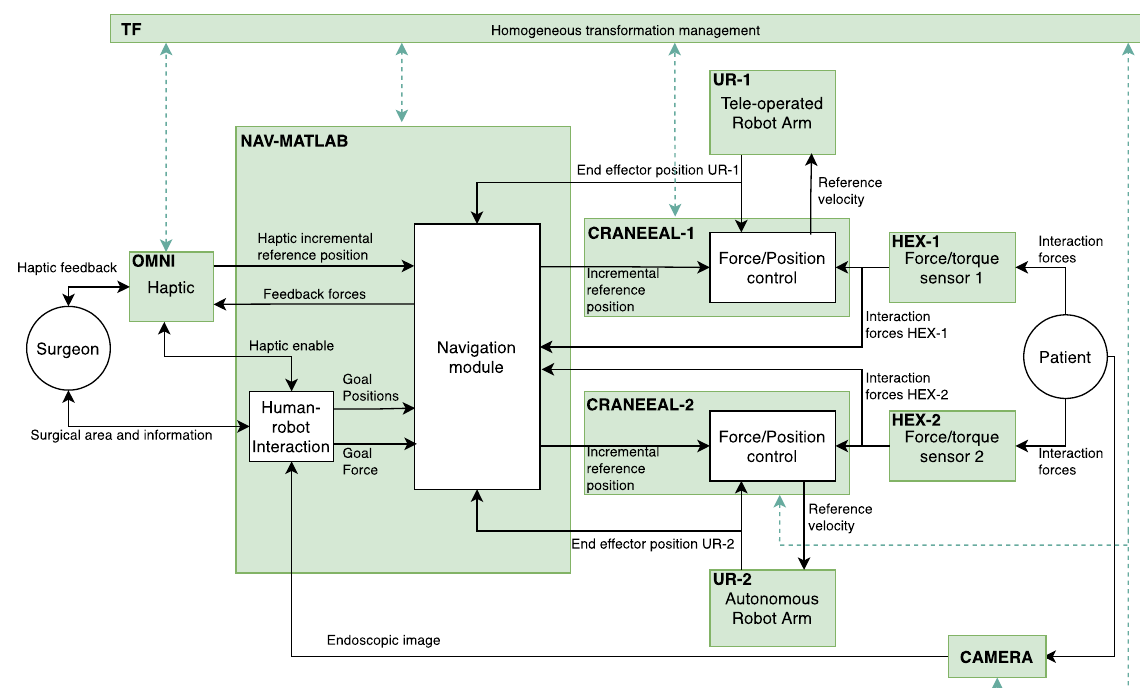
Figure 2. Robotic operating system ( ROS) implementation of the Functional Architecture.